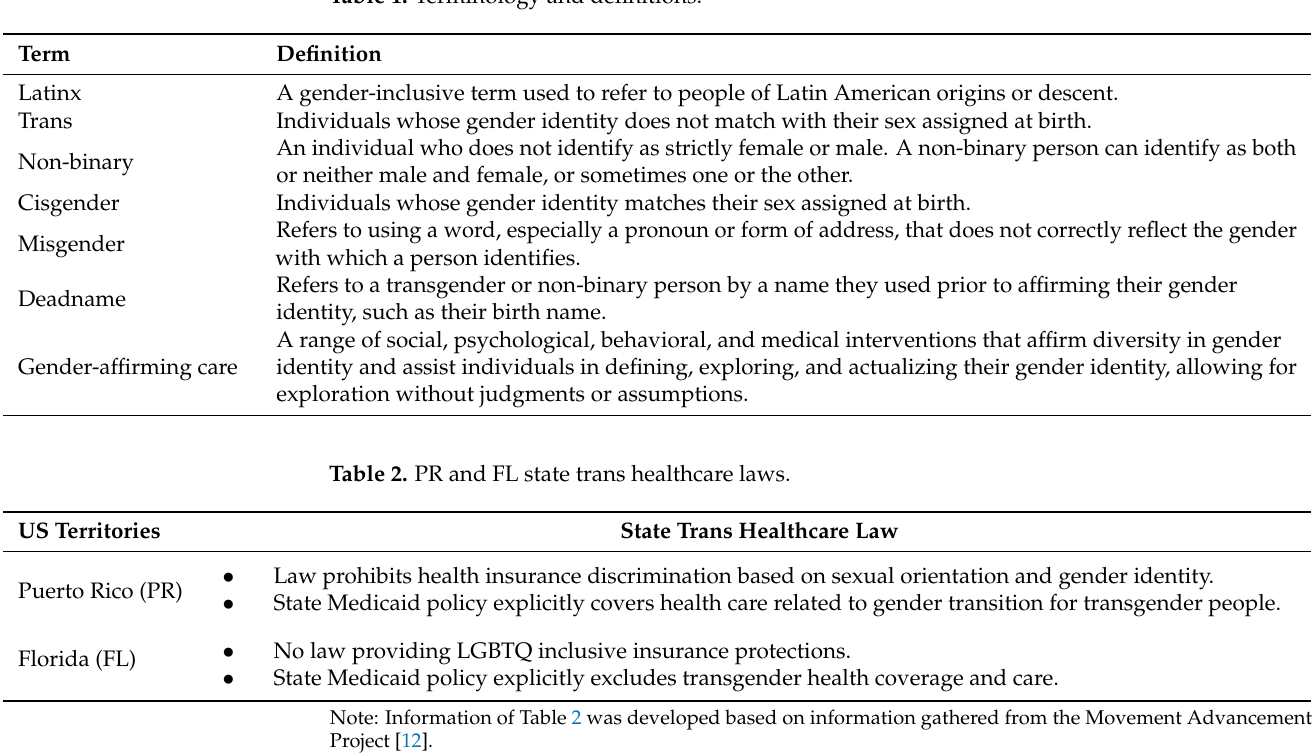
Table 1. Terminology and definitions.